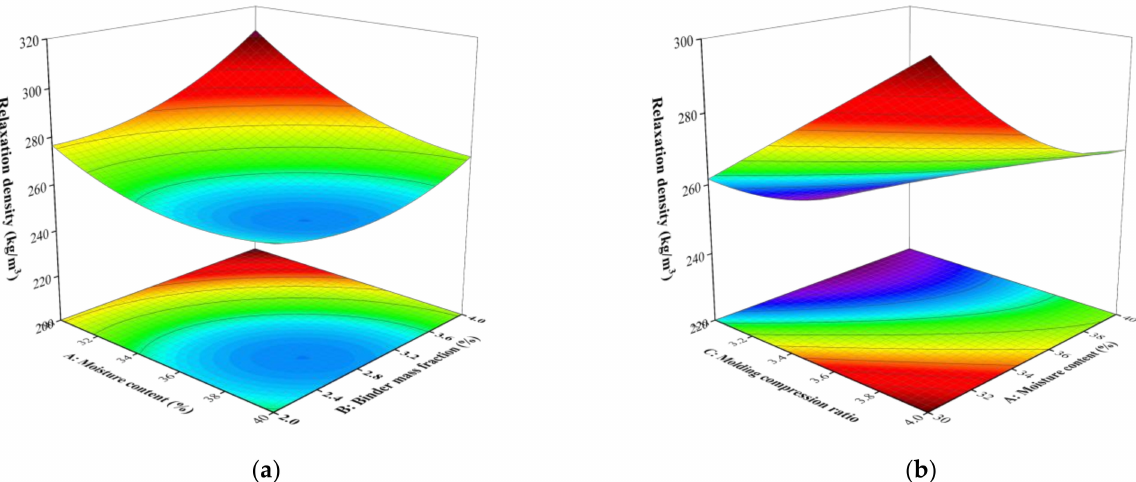
Figure 3. Interaction effect on relaxation density. ( a ) Effect of moisture content and binder mass fraction on relaxation density with the molding compression ratio of 3.5:1 and strain maintenance time of 60 s; ( b ) Effect of molding compression ratio and moisture content on relaxation density with the binder mass fraction of 3% and strain maintenance time of 60